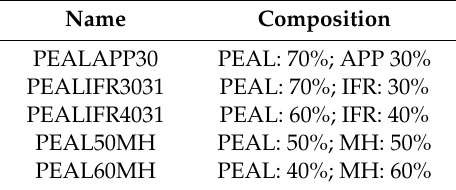
Table 1. Name and composition of the tested materials (percentages in % w